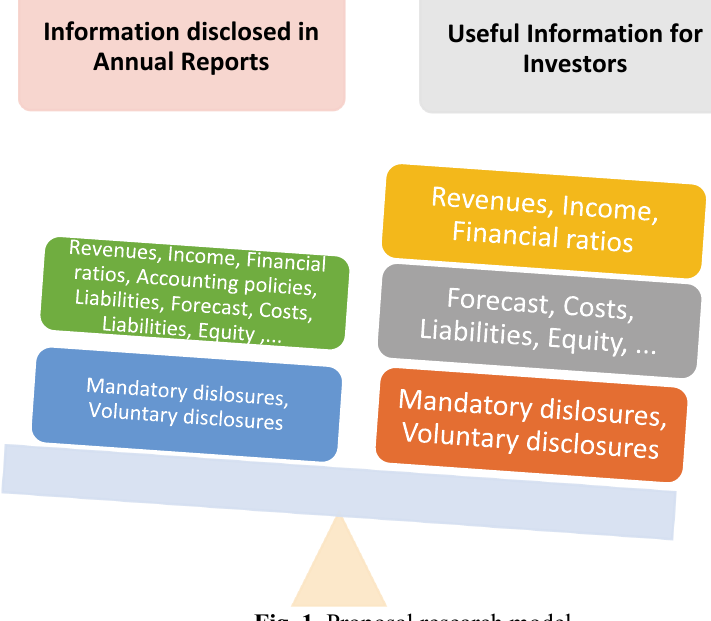
Fig. 1. Proposal research